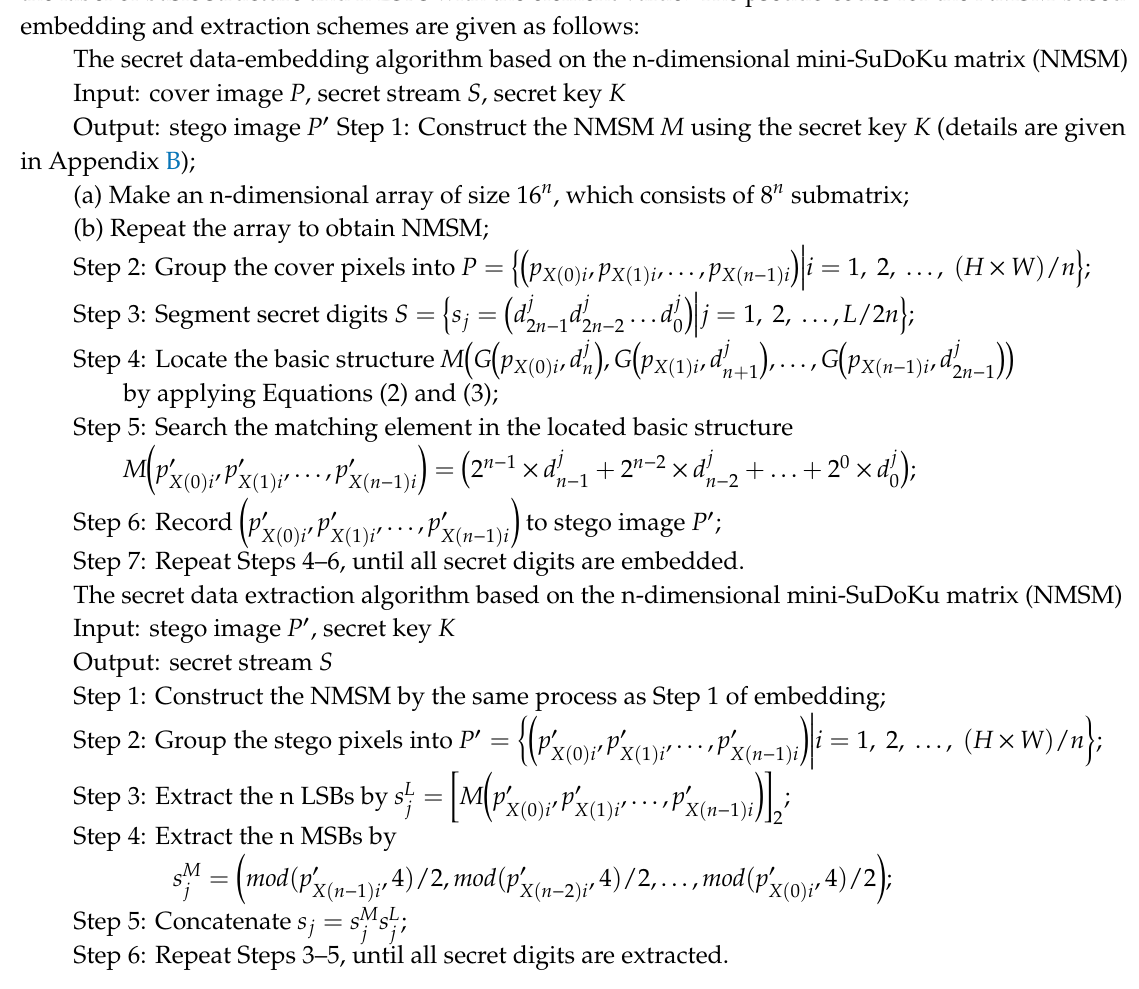
The secret data-embedding algorithm based on the n-dimensional mini-SuDoKu matrix (NMSM)